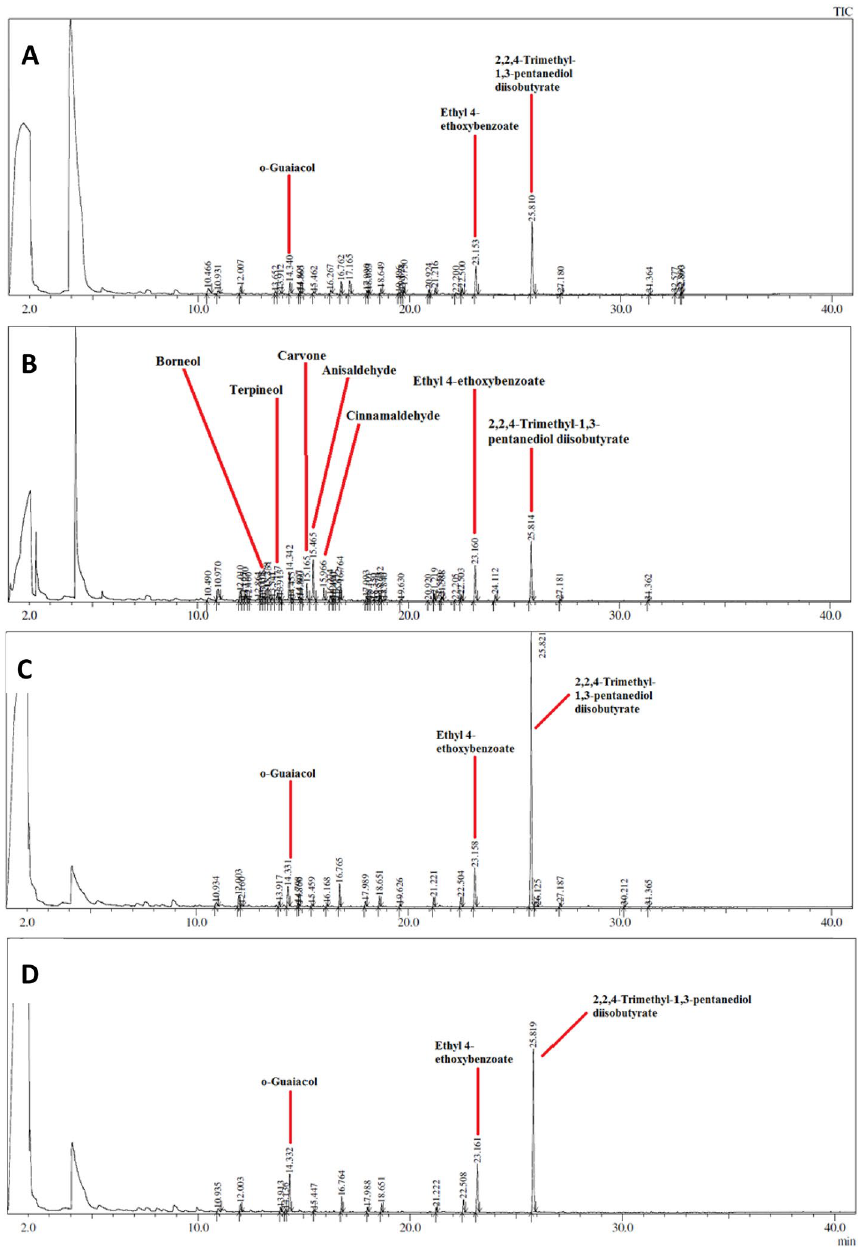
Figure 2. GC–MS headspace analysis of 0 µL injections of ( A ) aqueous; ( B ) methanolic; ( C ) ethyl acetrate and; ( D ) hexane Handroanthus impetiginosus (Mart. ex DC.) Mattos (Bignoniaceae) bark extracts with the major components (based on peak area)